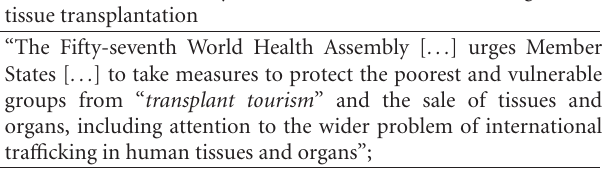
Table 2: Definition and prohibition of transplant